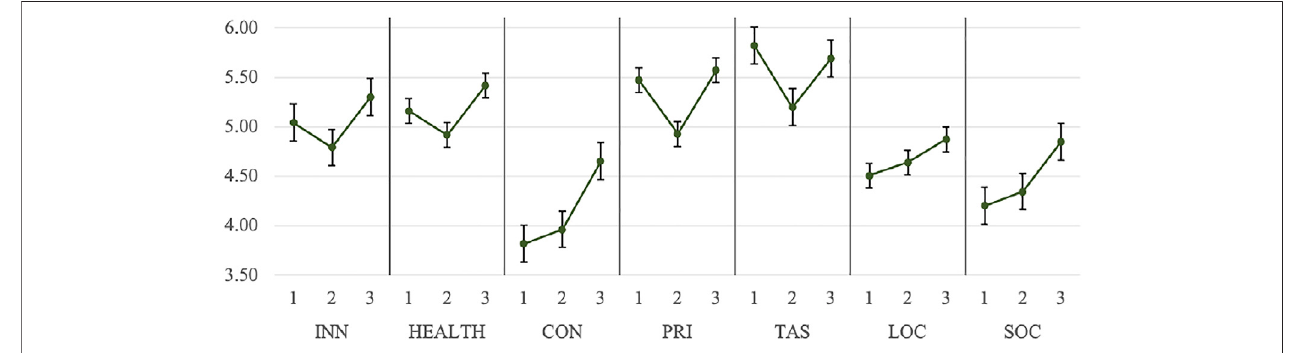
GRAPH 1 | Relationship between clusters and food-related lifestyle dimensions.